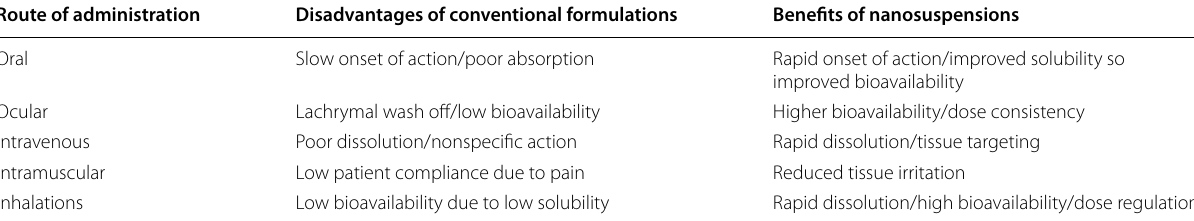
Table 1 Advantages of Nano suspension over conventional formulation Route of